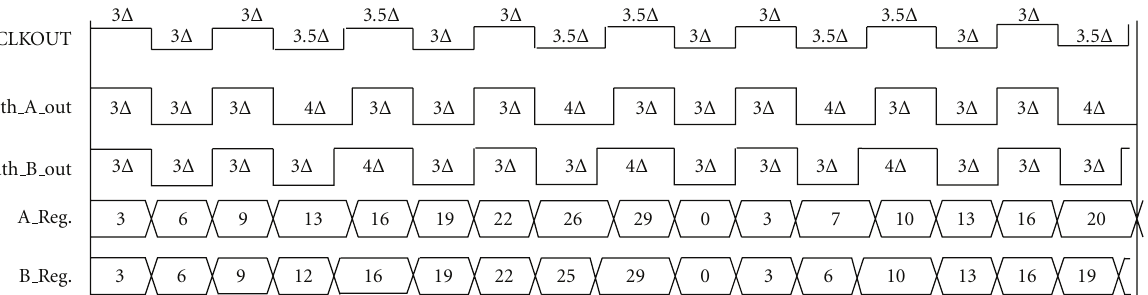
Figure 6: Numerical operation of proposed interpolated flying adder.